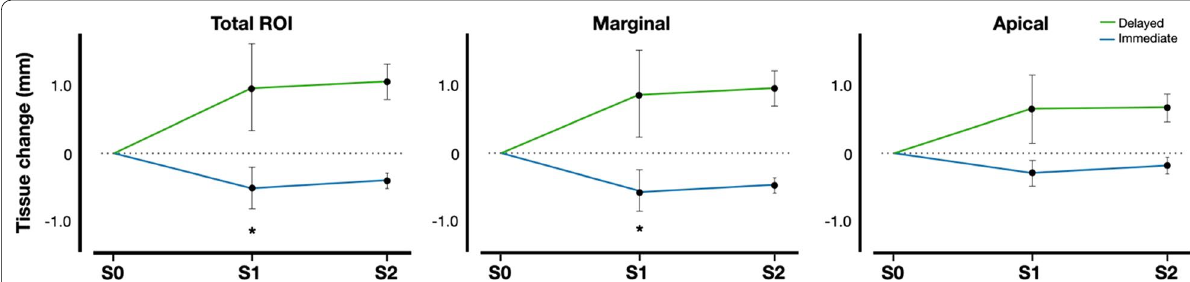
Fig. 5 Peri-implant tissue volume changes after 6 (S0–S1) and 12 months (S1–S2) in immediate and delayed placed implants groups. A Entire ROI, B marginal, and C apical sections. Values are expressed as mean SD of 16 implants per group. * p < 0.05 ±